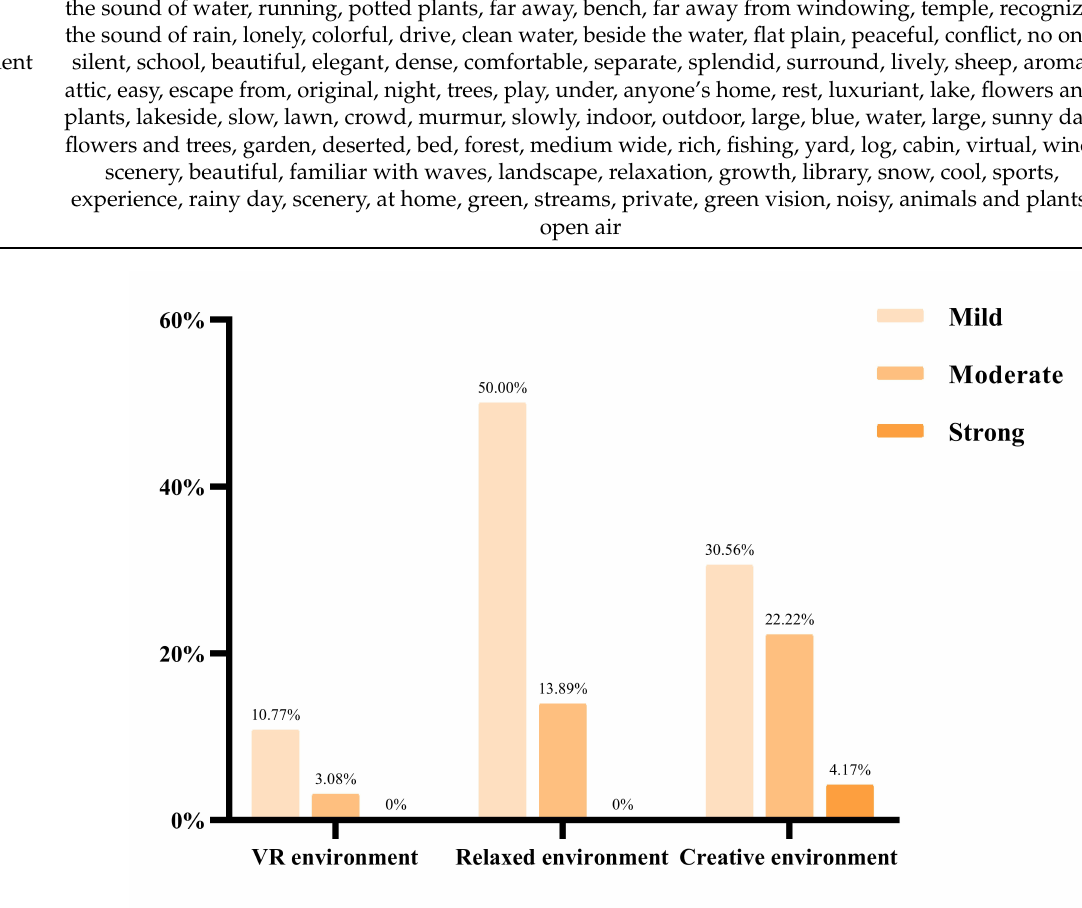
Figure A4. Comparative analysis results of positive affective